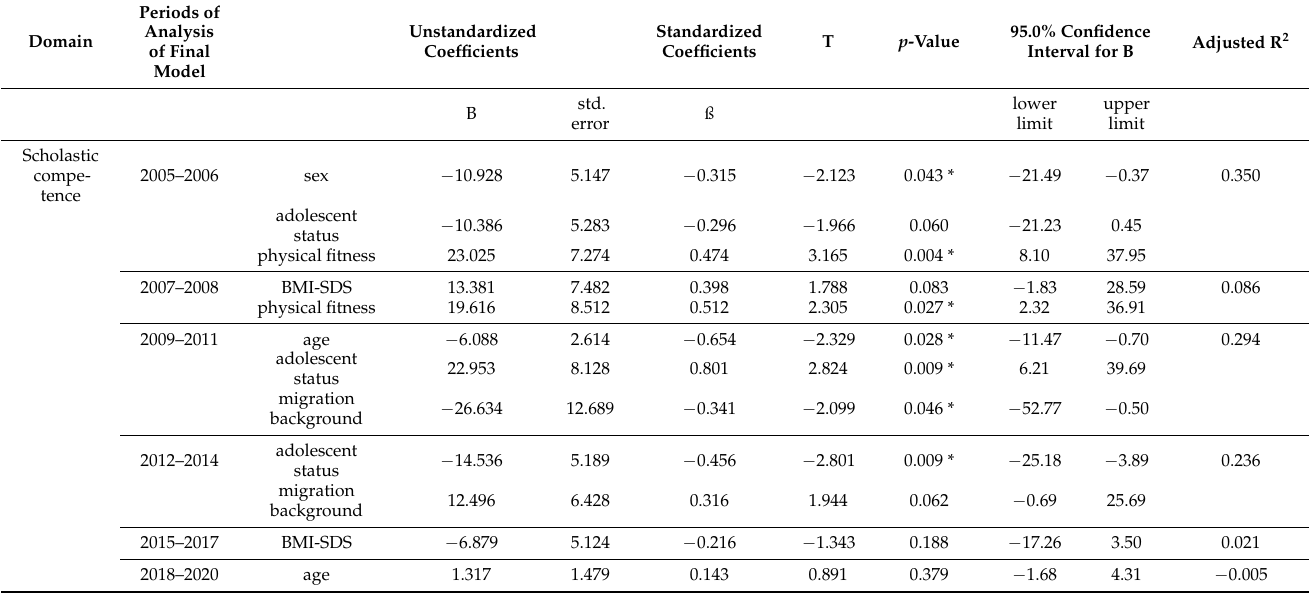
Table 5. Linear regression analysis (backward) of the scholastic competence domain.